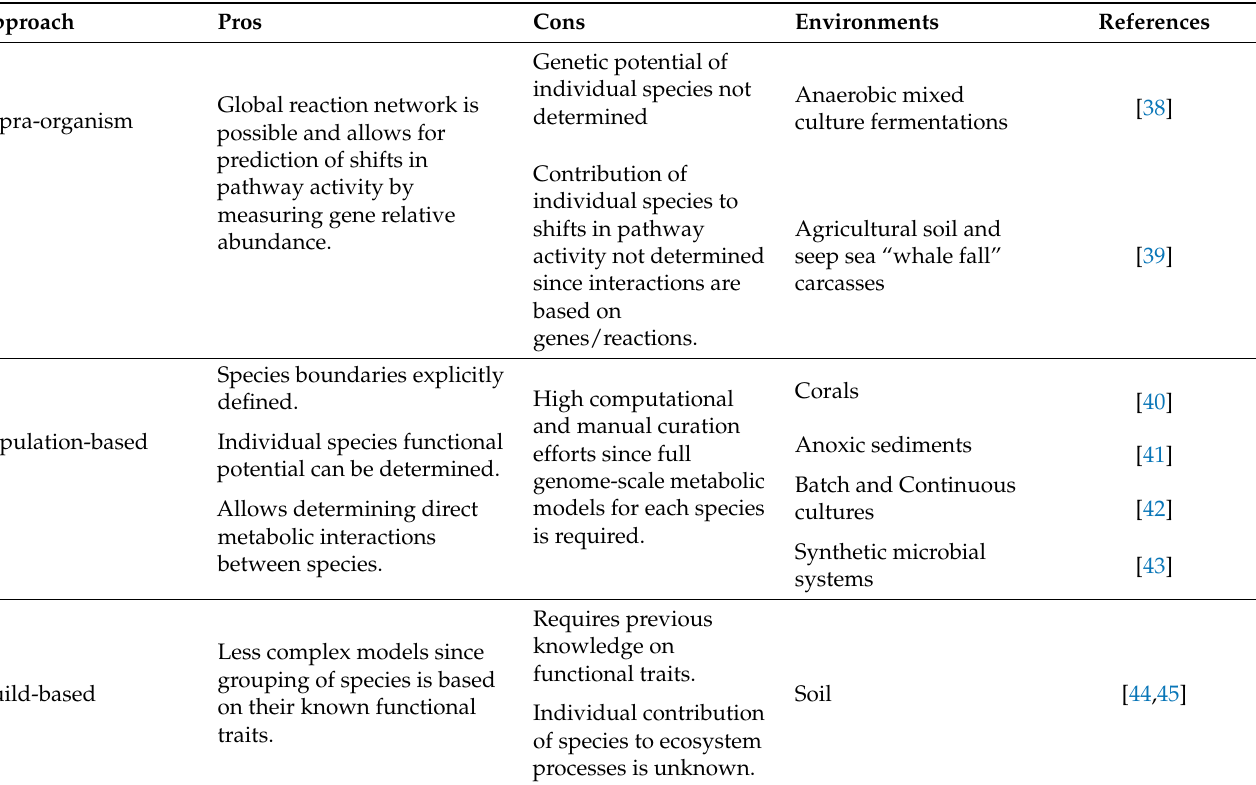
Table 1. Pros and cons of current modelling approaches to predict microbial interactions, environments where the selected approaches have been used and respective